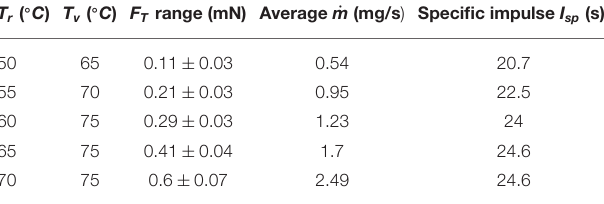
TABLE 1 | Measured thrust F T , and calculated mass flow rate ˙ m and specific impulse I sp of the naphthalene cold gas thruster for various reservoir and valve temperatures T r and T v ,